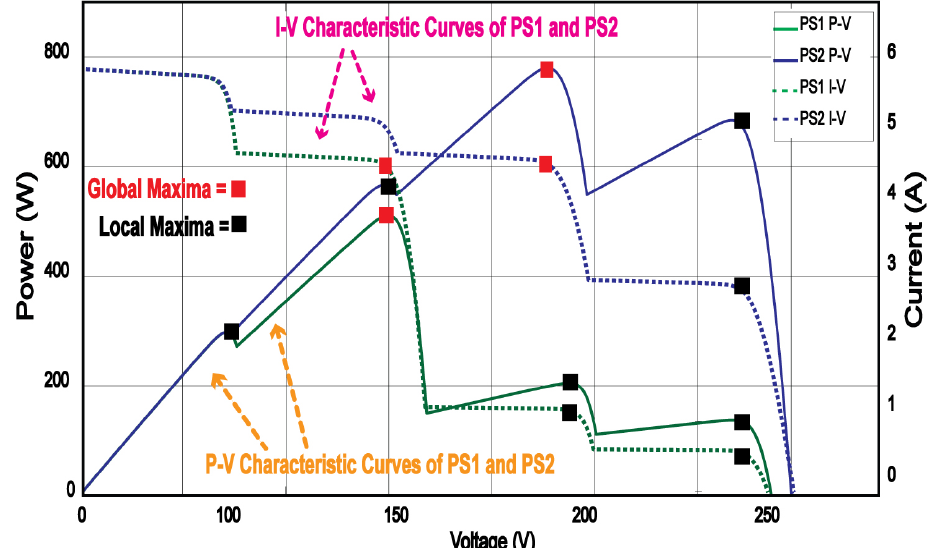
Figure 10. P-V and I-V Characteristics Curves for Partial Shading Cases 2 and